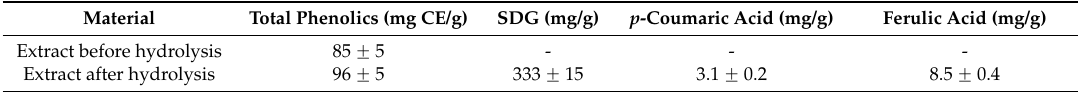
Figure 3. RP-HPLC chromatograms of extract after hydrolysis: ( 1 ) p -coumaric acid glucoside (CoAG); ( 2 ) ferulic acid glucoside (FeAG); ( 3 ) SDG; ( 4 ) p -coumaric acid; and ( 5 ) ferulic acid. Table 1. Content of total phenolics and individual phenolic compounds in flaxseed extract and its hydrlolysate.